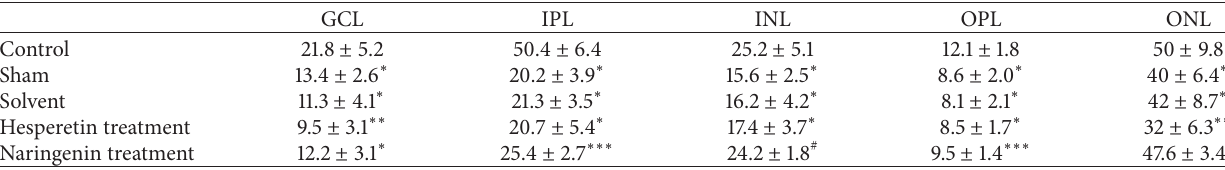
Table 1: Thickness of the rat’s retina ( 𝜇 m).